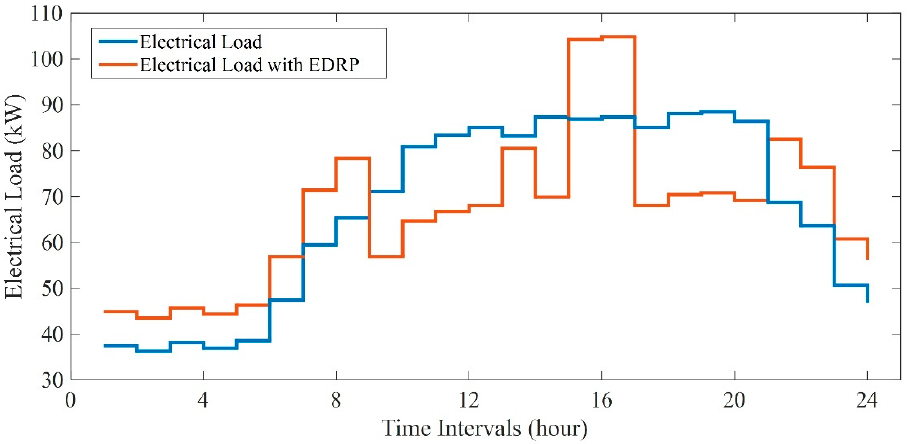
Figure 3. Electrical load with/without electrical demand response programs (EDRP) on the typical winter day.